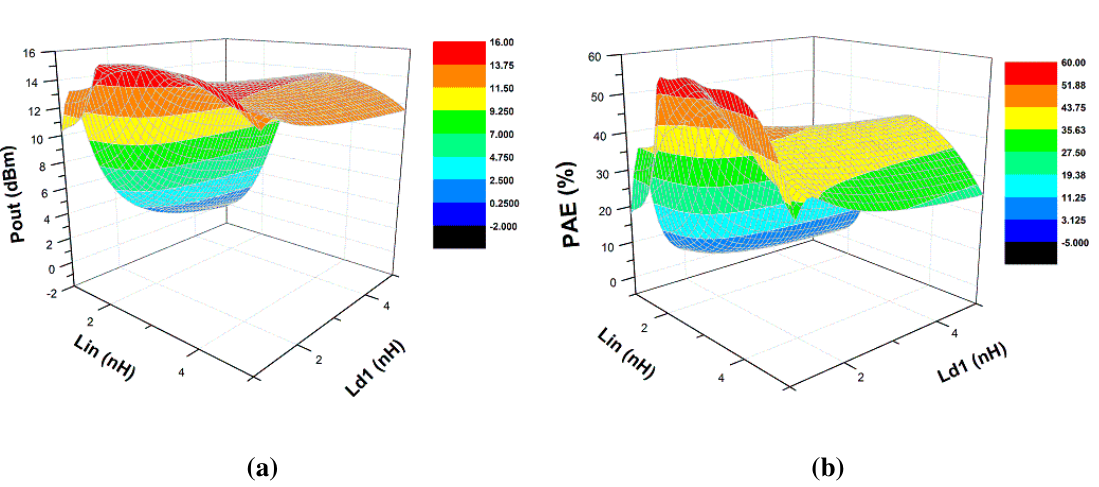
Figure 17. ( a ) Output power versus L and L d 1